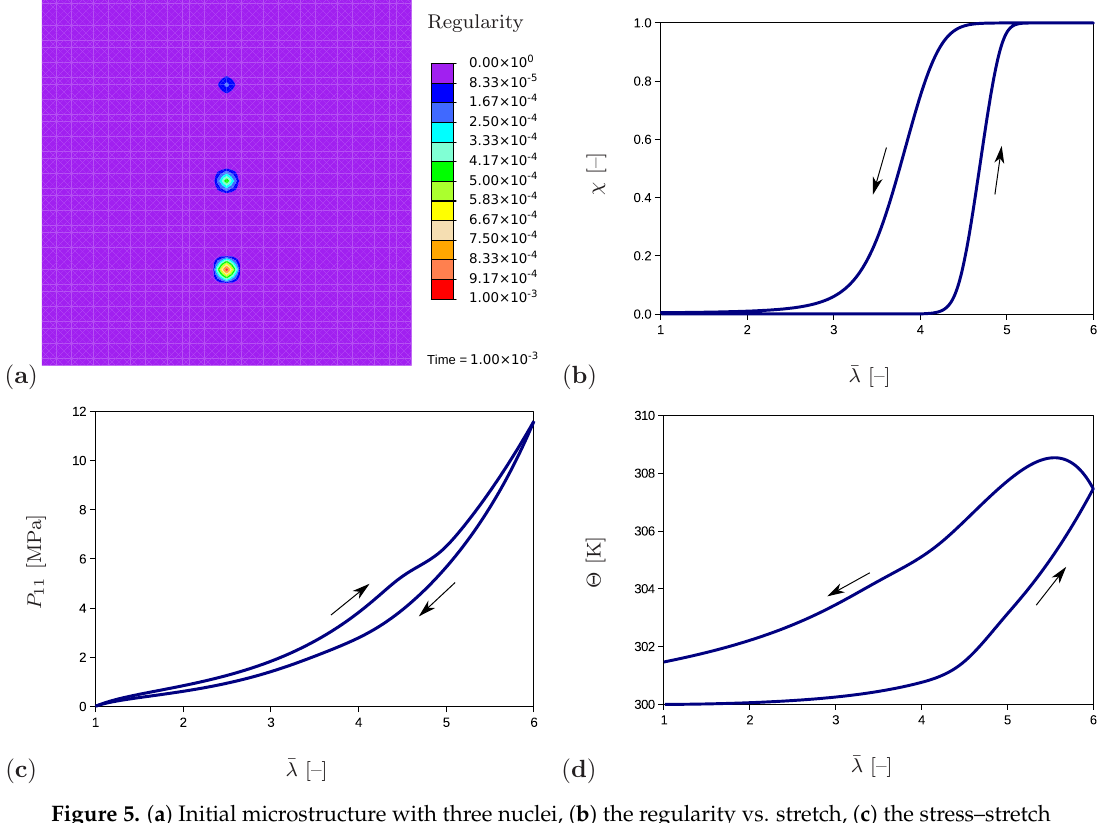
Figure 5. ( a ) Initial microstructure with three nuclei, ( b ) the regularity vs. stretch, ( c ) the stress–stretch diagram, and ( d ) the temperature change over the stretch at the crystalline region in the bottom part of the